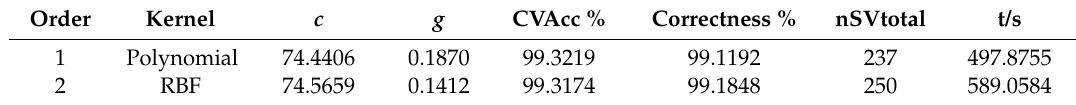
Table 3. Comparison of evaluation indexes between polynomial and RBF kernel function.